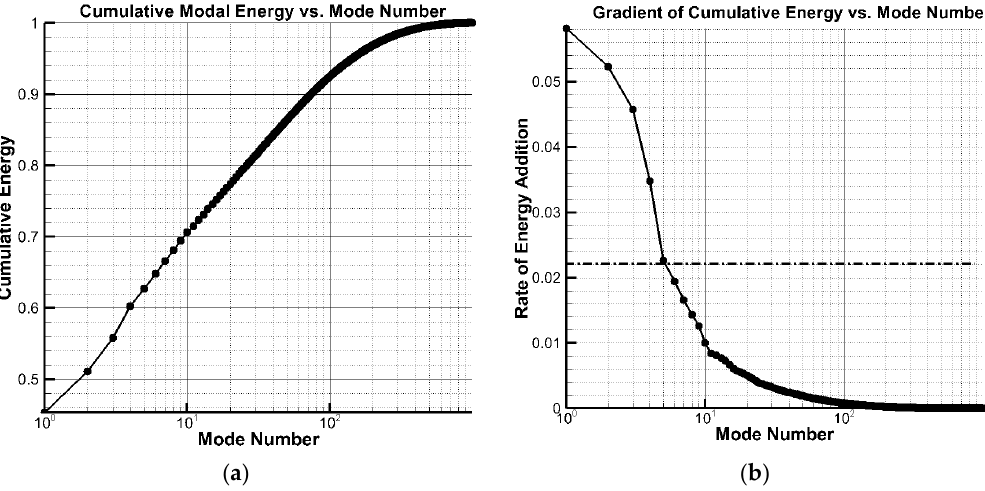
Figure 7. POD analysis results in terms of cumulative modal energy and the rate of energy addition. ( a ) Cumulative modal energy. ( b ) The rate of energy addition.